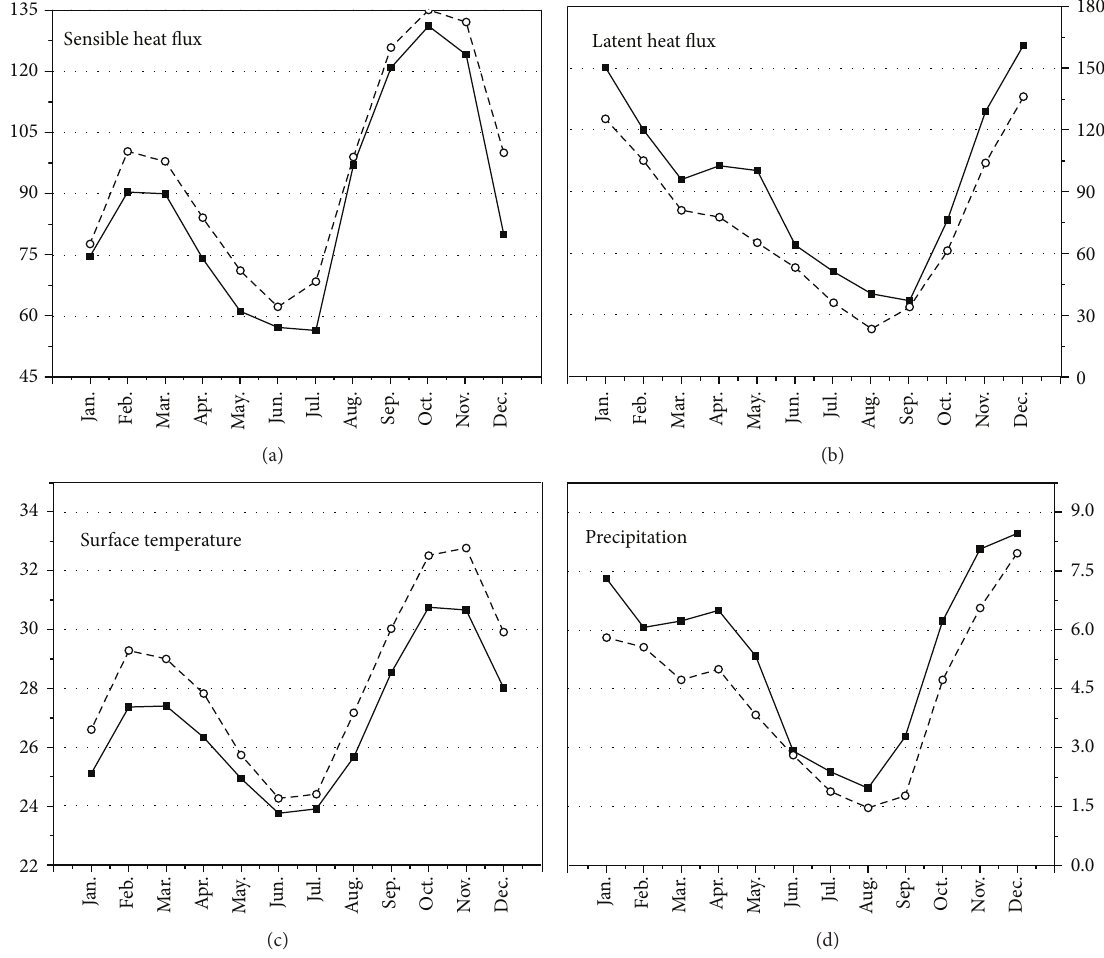
Figure 2: Annual cycles’ domain-averaged in the years 2090–2100 between 49 ∘ W and 63 ∘ W and 12 ∘ S and 2 ∘ N. All flux is in W/m 2 , surface temperature in ∘ C, precipitation in mm. Solid line is the control simulation, and the dashed line is deforestation